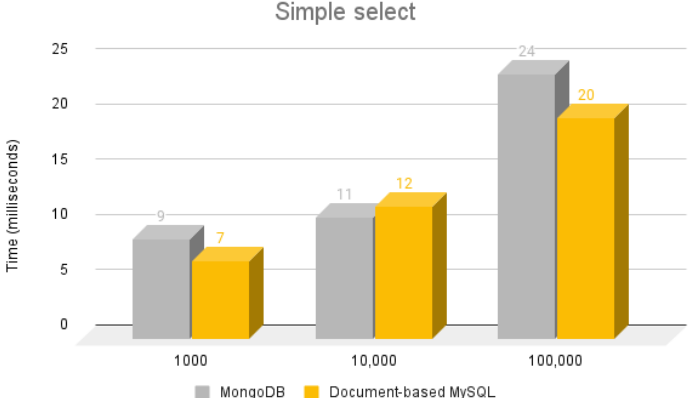
Figure 5. Execution times for the simple select operation.